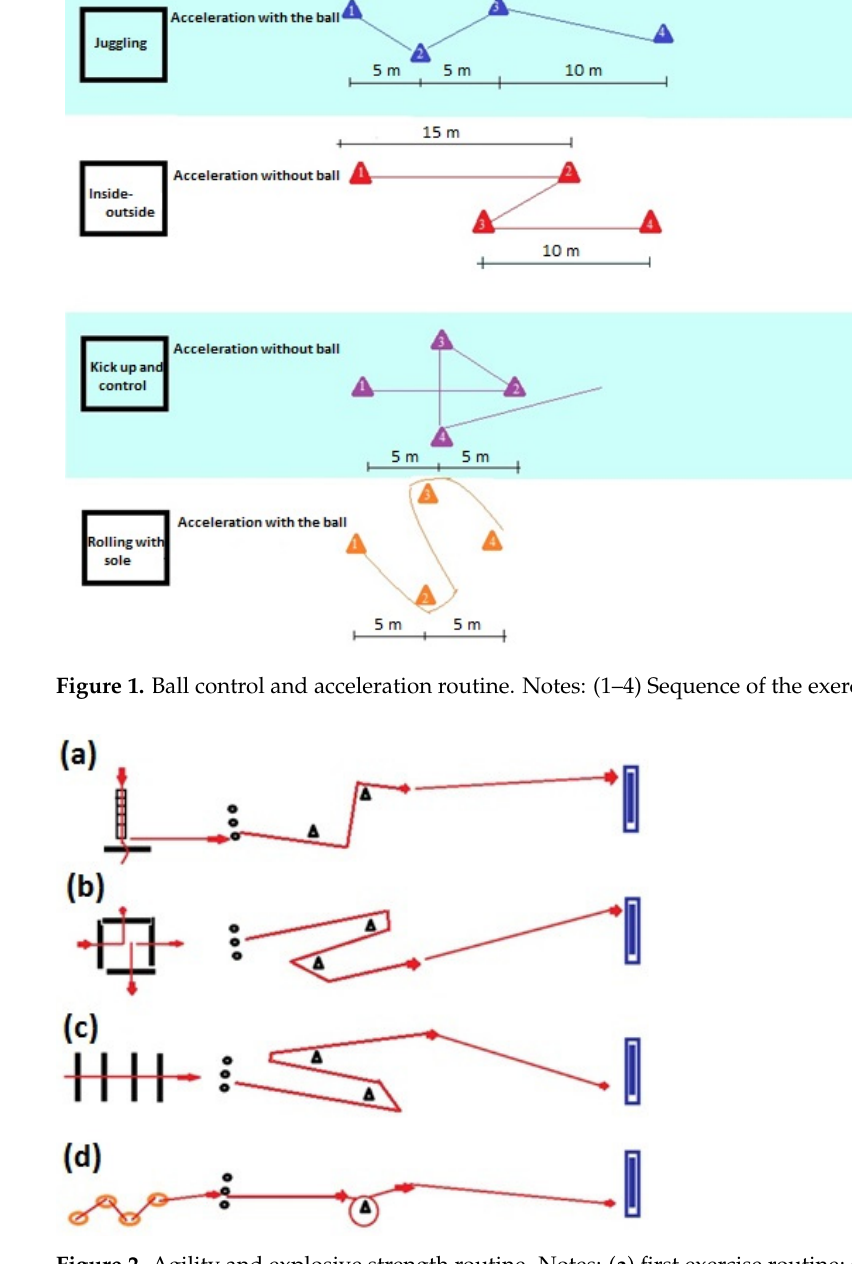
Figure 2 . Agility and explosive strength routine. Notes: (a)— first exercise routine; ( b ) — second exercise routine; ( c ) — third exercise routine; ( d)— fourth exercise